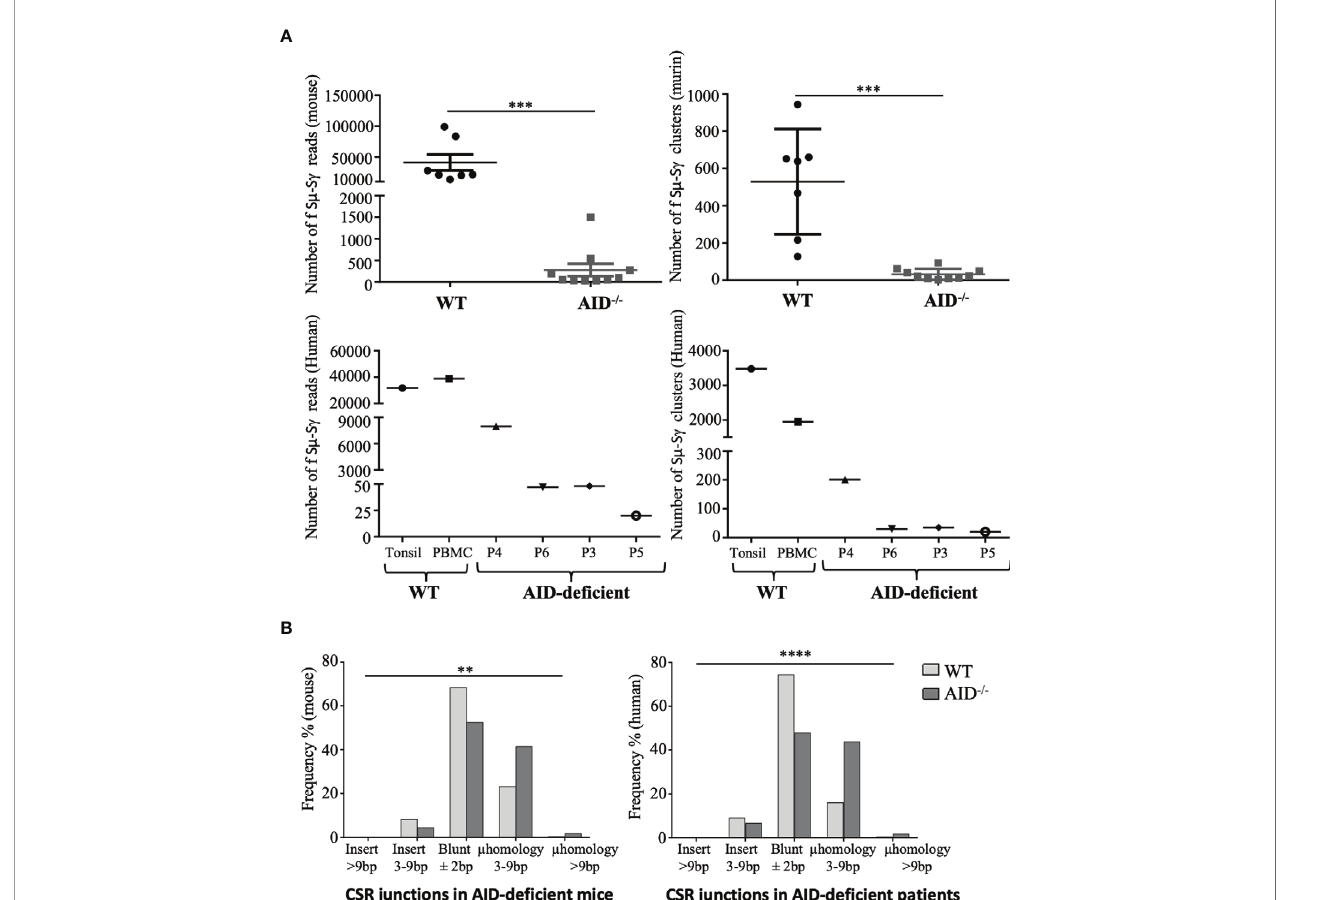
FIGURE 3 | Class switch recombination (CSR) in murine and human activation-induced deaminase (AID)-de fi cient samples. (A) Sµ-S g murine CSR junctions were PCR-ampli fi ed and sequenced from spleen B-cells at 17 days after sheep red blood cell immunization, comparing mutant and control mice (top). Sµ-S g human CSR junctions were also PCR-ampli fi ed and sequenced from blood and tonsils from AID-de fi cient human samples (bottom). Numbers of independent reads including Sµ – S g junctions are shown on the left graph. Independent reads including the same CSR breakpoint were assembled and considered as clusters; numbers of independent clusters are shown on the right graph. Junction structures were analyzed using CSReport. (B) Structures of repaired junctions were analyzed depending on the mean number of inserted nucleotides and length of microhomologies between the broken ends of S m -S g junctions in WT and AID-de fi cient samples. c 2 test was used for signi fi cance of IgG CSR structure analysis. **p < 0.01; ***p < 0.001; ****p <